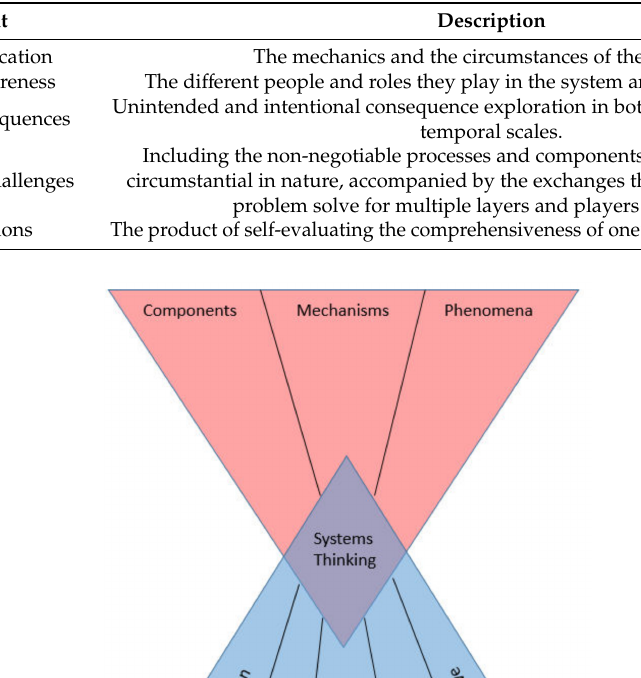
Table 2. Components of systems thinking [21].